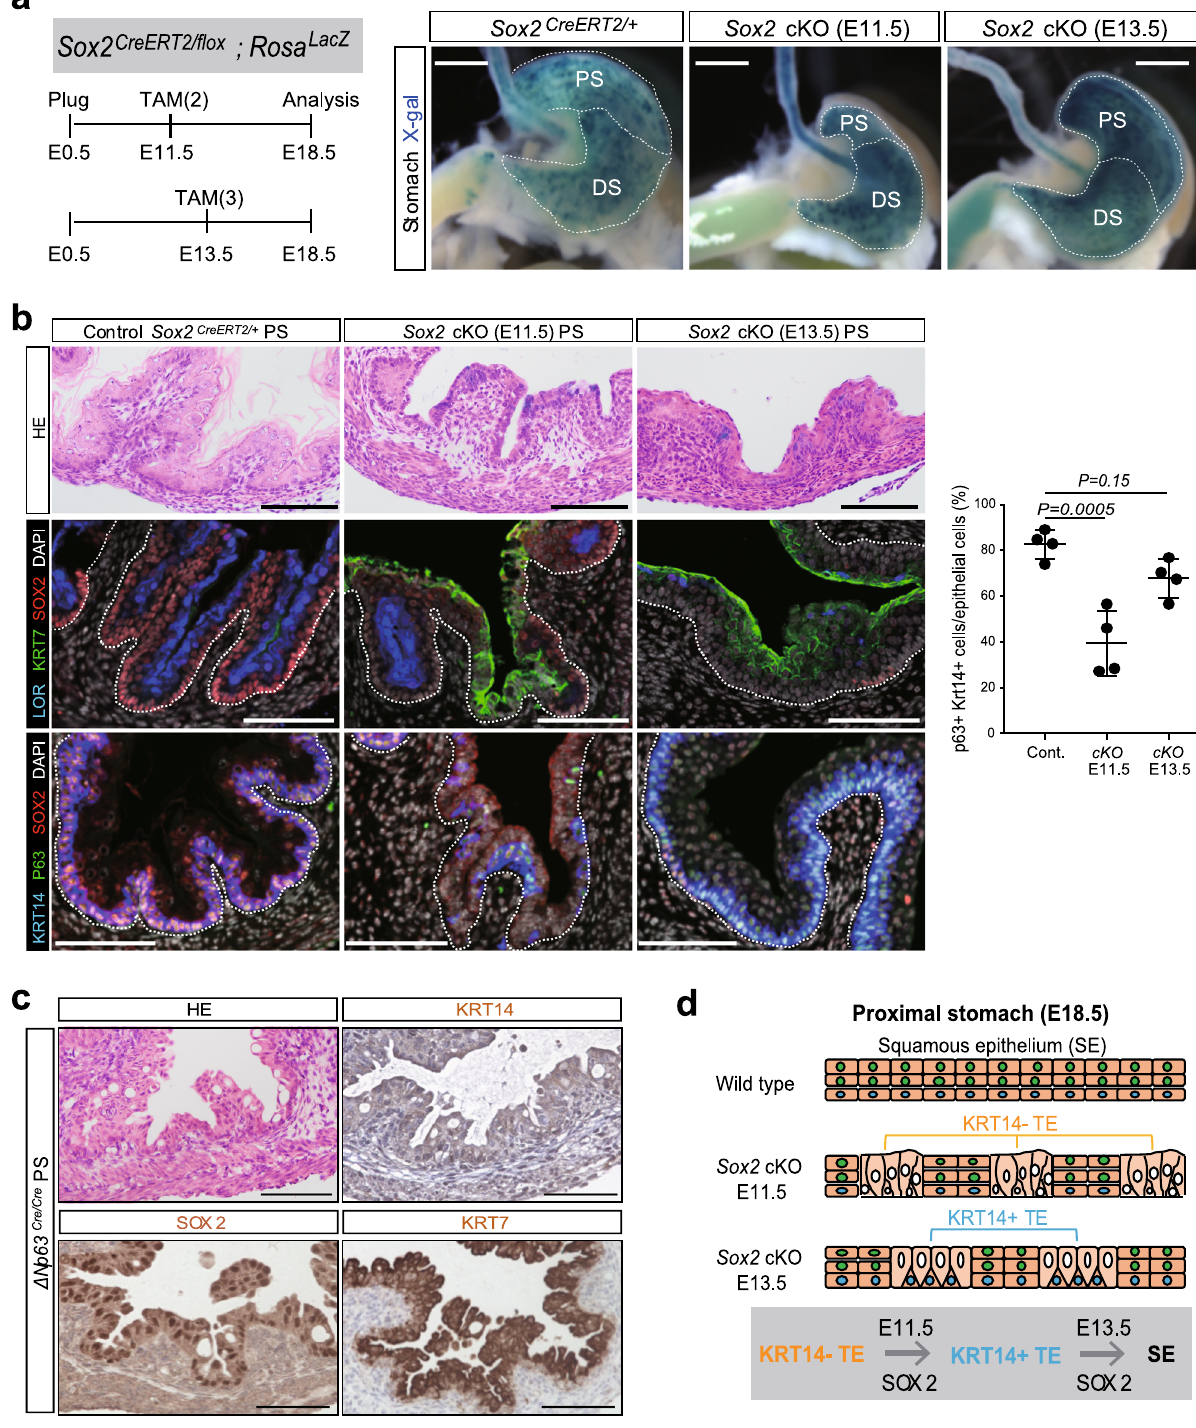
Fig. 2 SOX2 speci fi es primitive transitional epithelium into squamous epithelium. a Left: the scheme for the Sox2 conditional knock out ( Sox2 cKO ) experiment in the embryonic stomach. Right: the whole-mount X-gal staining on the control, Sox2 cKO (E11.5) , and Sox2 cKO (E13.5) stomachs at E18.5. Presented data are a representative image of n = 4 embryos out of three independent experiments. Scale bar, 1 mm. b Left: H&E staining and IF analyses of LOR, KRT7, and SOX2 (top), or P63, KRT14, and SOX2 (bottom) for the control, Sox2 cKO (E11.5) , and Sox2 cKO (E13.5) stomachs at E18.5. Presented data are a representative image of n = 4. Scale bar, 100 µ m. Right: quanti fi cation of the number of the P63 + KRT14 + basal cells in the proximal epithelial cells. Data are presented as mean values ± SD. n = 4 independent experiments, one-way ANOVA. c H&E staining and IHC analyses of SOX2, KRT14, and KRT7 for the Δ Np63 KO proximal stomach at E18.5. Presented data are a representative image of three independent experiments. Scale bar, 100 µ m. d A scheme illustrates the Sox2- mediated speci fi cation of the primitive transitional epithelium into the squamous epithelium. SE squamous epithelium, TE transitional